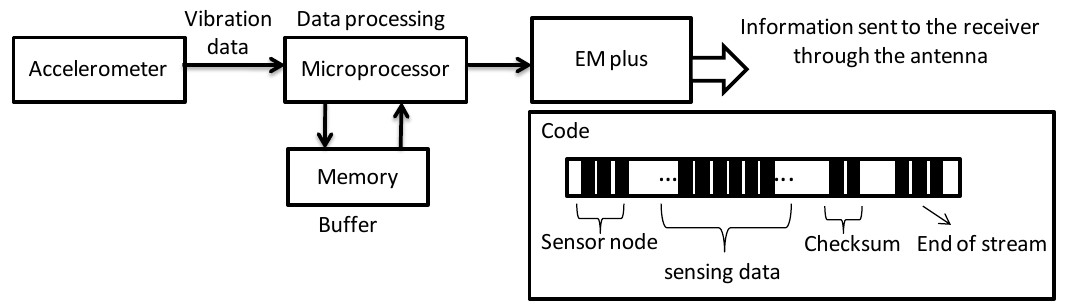
Figure 2. Schematic view of the signal processing and encoding of the wireless and powerless fault diagnosis